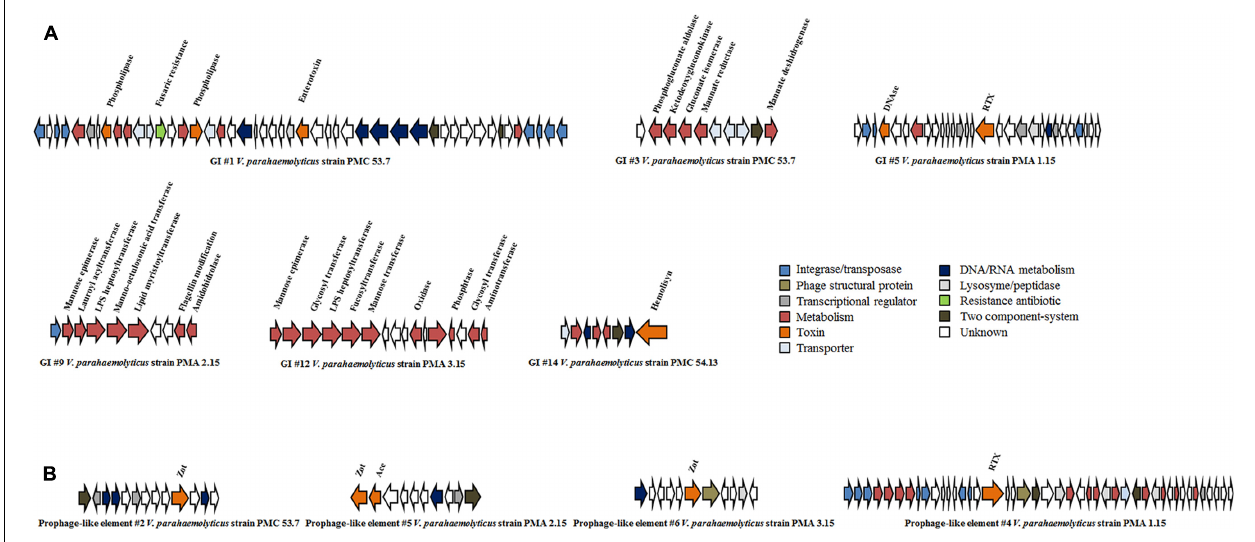
FIGURE 4 | Schematic representation of accessory elements carrying virulence or fitness factors in the V. parahaemolyticus strains. (A) Genomic islands in V. parahaemolyticus strains PMC 53.7, PMC 54.13, PMA 1.15, PMA 2.15, and PMA 3.15. Position of GIs and prophage-like element are shown in Tables 4 , 5 , respectively. The colors were assigned according to the possible role of each ORF as shown in the figure. (B) Prophage-related elements in V. parahaemolyticus strains PMC 53.7, PMA 2.15, PMA 3.15, and PMA 1.15 that encode a gene related to zonula occludens toxin ( zot ) or RTX toxin.